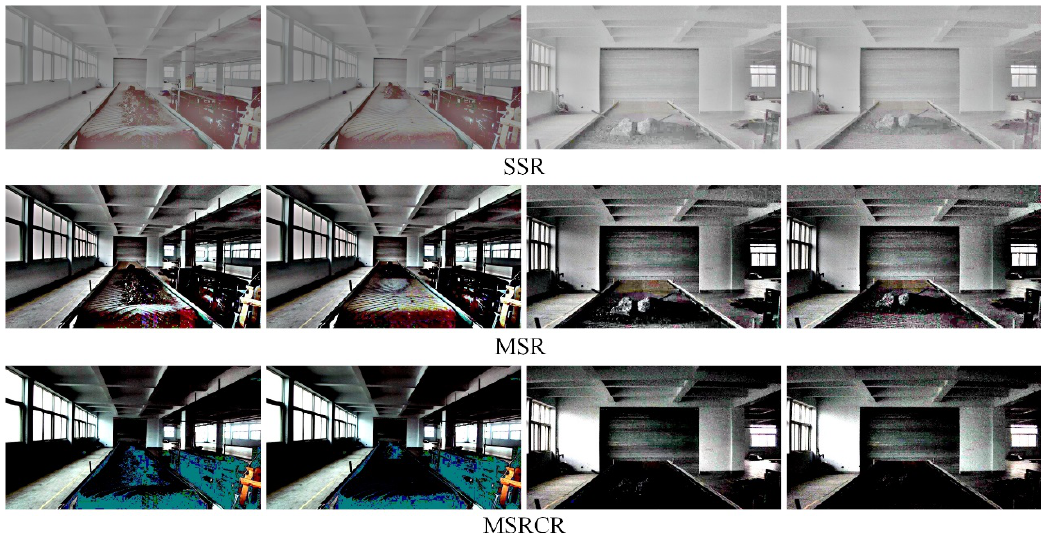
Figure 14. Enhancement of traditional algorithms for evening images without light source.